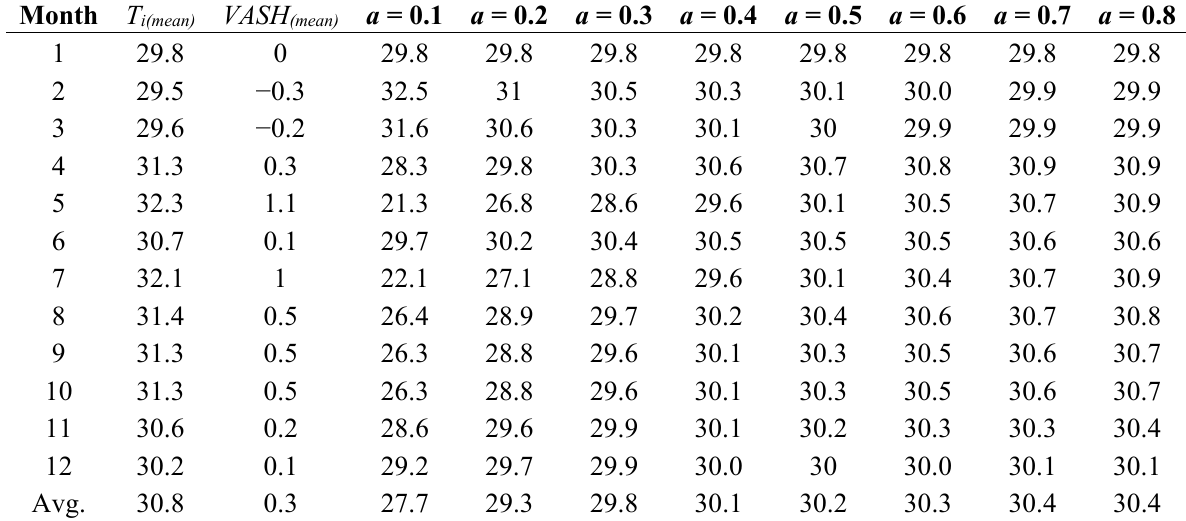
Table 4. Mean monthly comfort temperature according to the Griffiths method.